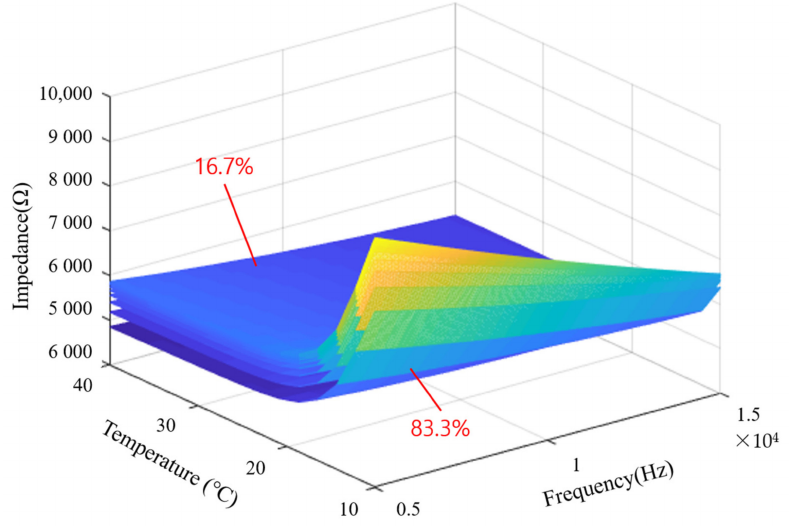
Figure 17. Impedance with temperature and frequency represented 3D surface form.